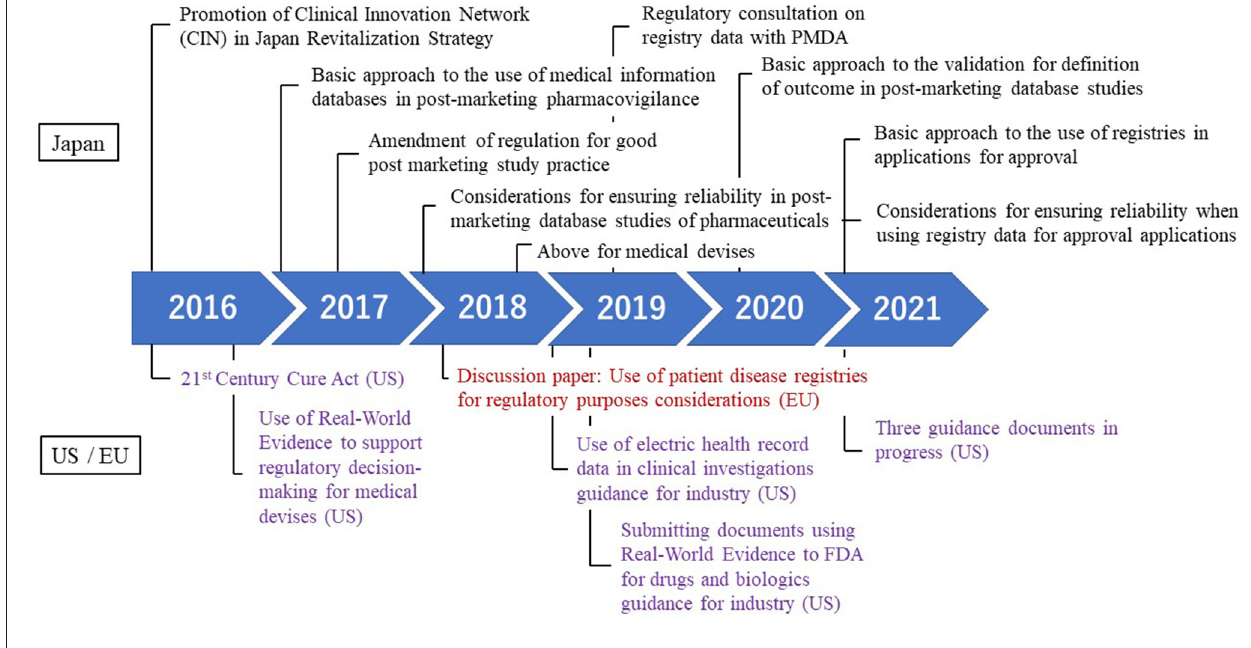
FIGURE 1 | Regulatory developments related to real world